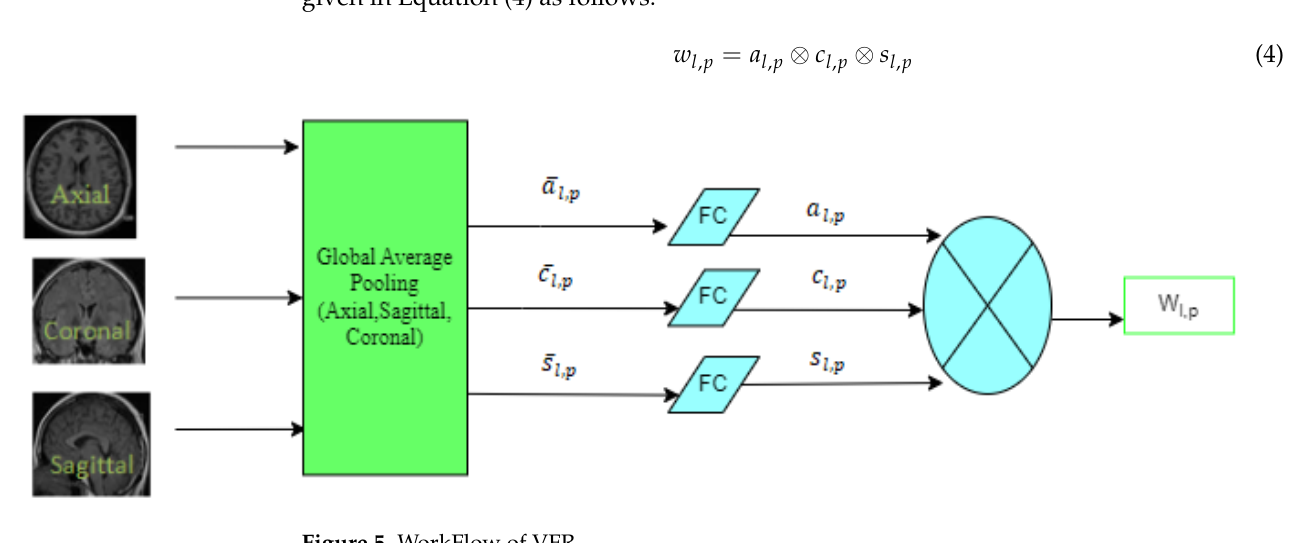
Figure 5. WorkFlow of VFR.